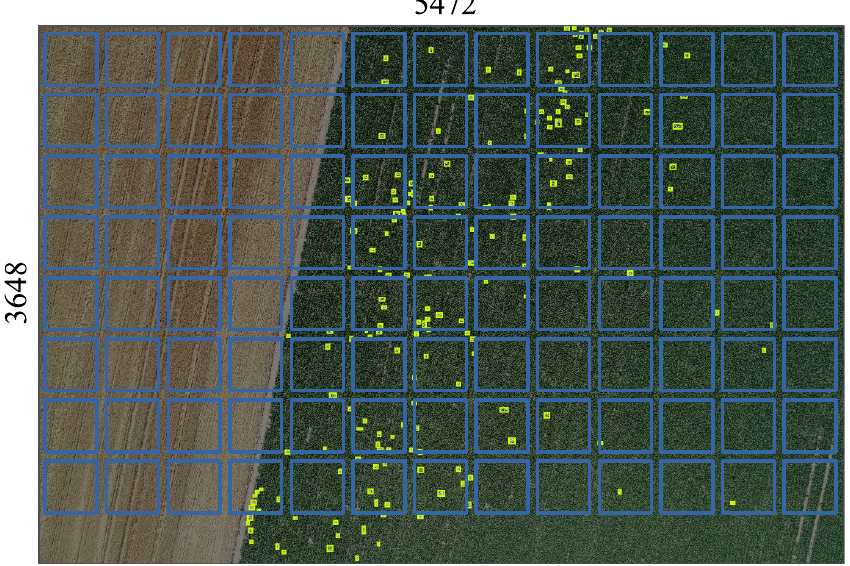
Figure 3. An example of an RGB image with dimensions of 5472 × 3648 pixels belonging to the Chicory Plants dataset proposed in this work. The yellow boxes identify weeds tagged by an expert. The 13 × 8 cells in blue represent the mosaic used to extract patches 416 × 416 in size to be fed into the neural model. Only patches containing at least one bounding box are used by the neural